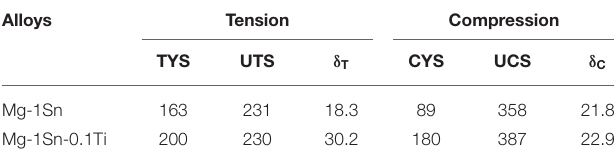
TABLE 2 | Mechanical properties of Mg-1Sn and Mg-1Sn-0.1Ti alloys. Alloys Tension